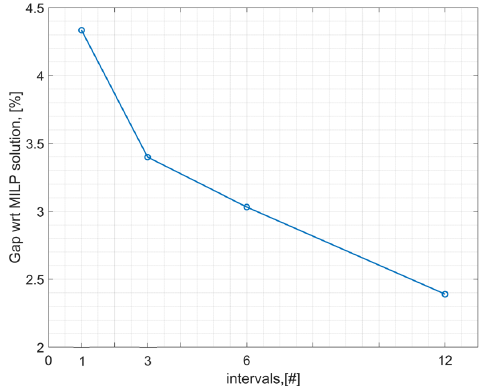
Figure 9. TRBH average percentage cost increase compared to the MILP solution as a function of the number of intra-day